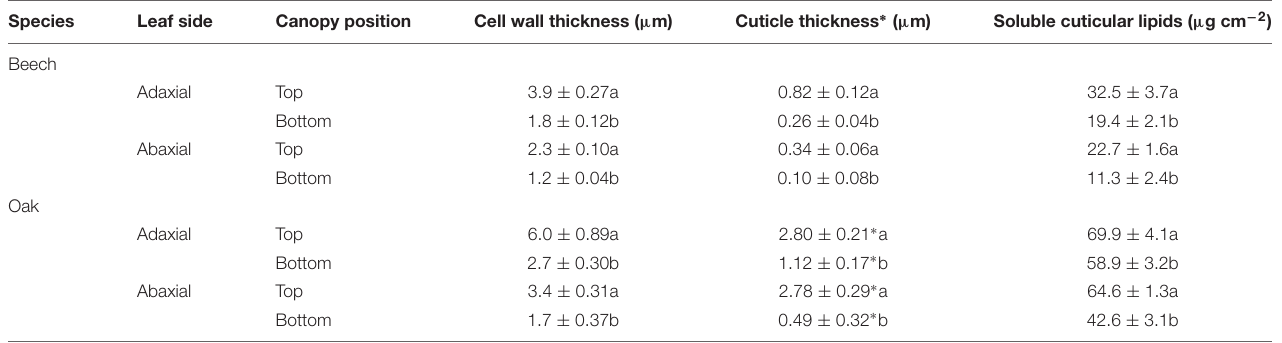
TABLE 2 | Adaxial and abaxial epidermal cell wall and cuticle thickness, and soluble cuticular lipids concentration per unit area of beech and sessile oak leaves collected from upper (top) or lower (bottom) canopy positions. Species Leaf side